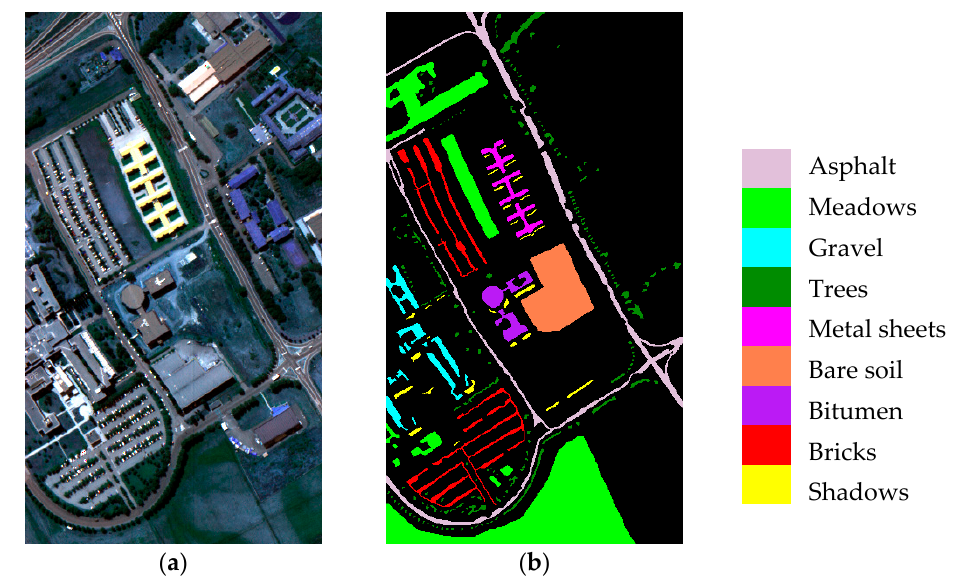
Figure 1. Pavia University dataset. ( a ) False-color image and ( b ) ground-truth image.